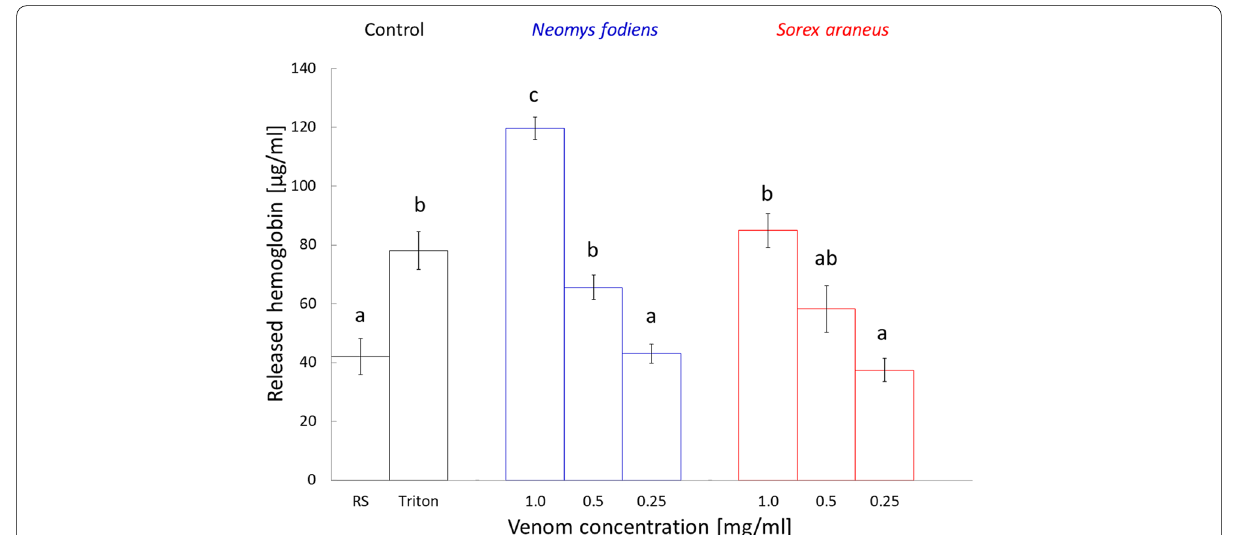
Fig. 2 Hemolysis produced by shrew venoms expressed as concentration of released hemoglobin. Bars represent mean represent significant differences between treatments, controls and